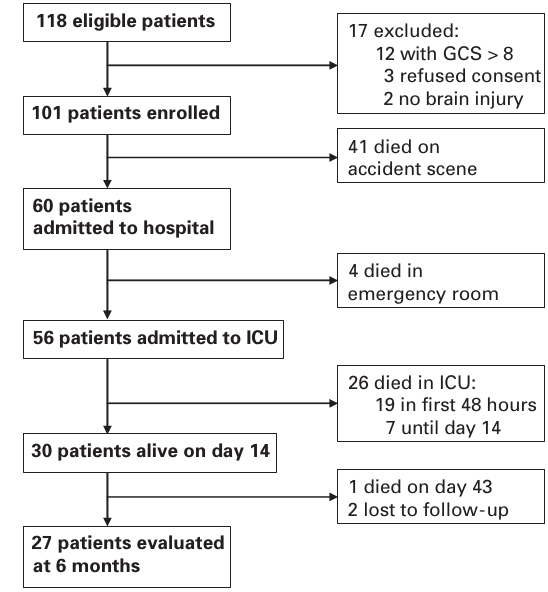
Figure 1 Flow chart of participants.